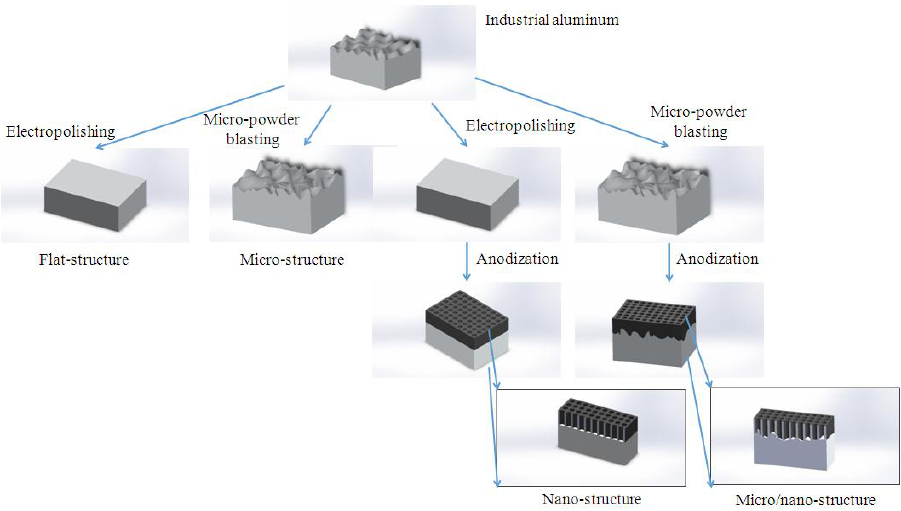
Figure 1. Fabrication process for different structures of aluminum (Al) templates.